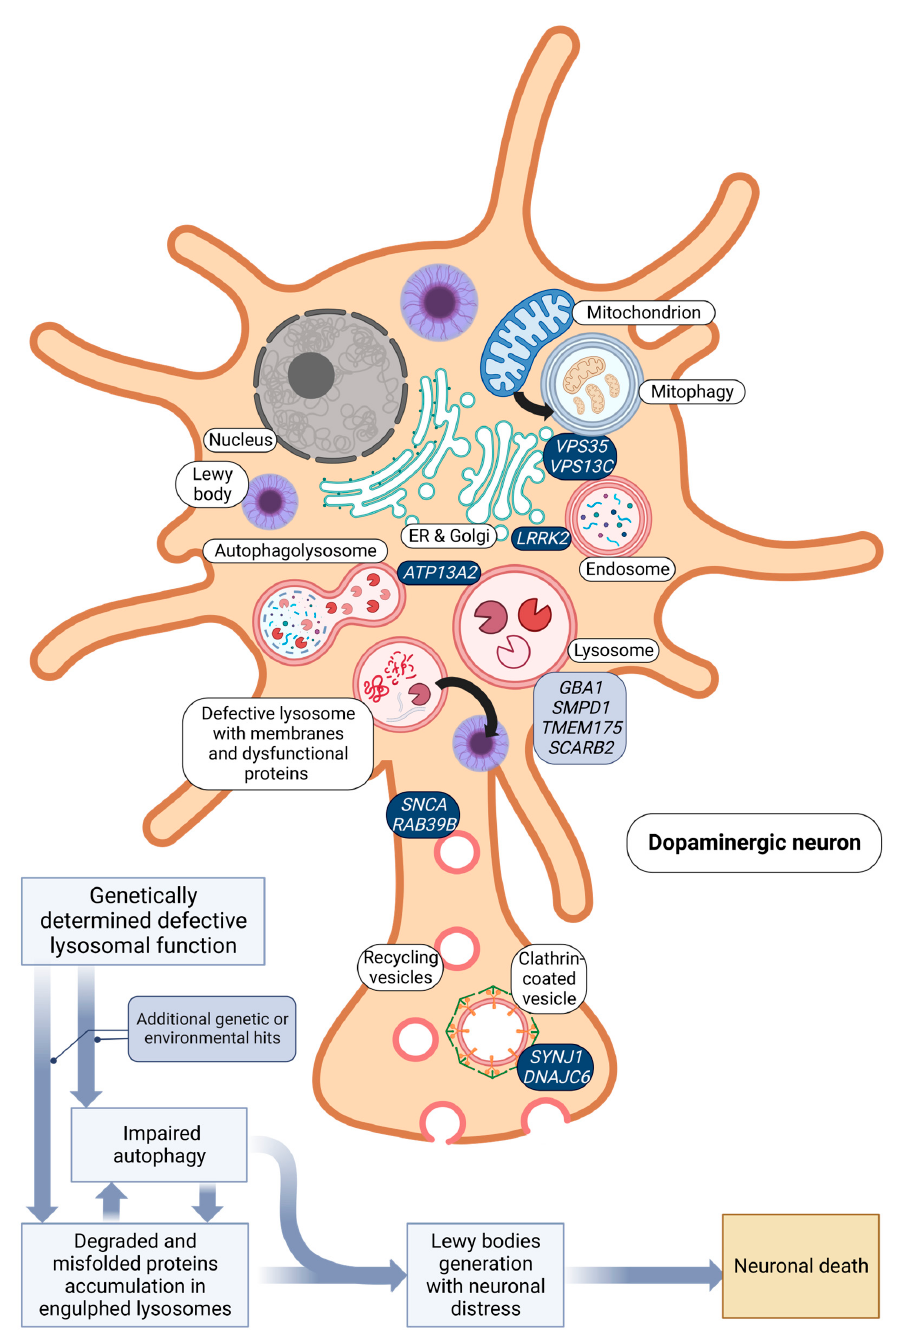
Figure 1. Graphic representation of a dopaminergic neuron illustrating the relevant intracellular organelles, the involved monogenic PD genes (dark blue), and PD risk genes (light blue). In the represented model, a genetically determined impairment of the endolysosomal function in association with additional genetic and environmental pathogenic hits causes a defect in the degradation of misfolded proteins (including α -synuclein), which induces a compensatory autophagic response to address the disposal of the pathological proteins. However, a defective endolysosomal pathway implies an ineffective autophagic response, thus triggering a self-feeding vicious cycle of abnormal protein accumulation by dysfunctional engulfed lysosomes. As a consequence, the accumulation of misfolded aggregated proteins and engulfed lysosomes–autophagosomes leads to the progressive formation of pathological inclusions (Lewy bodies) and ultimately to neuronal distress and death. Created with